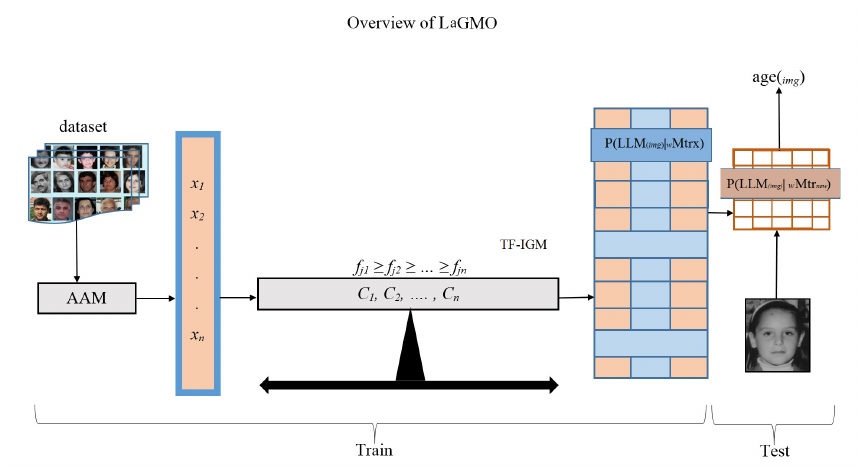
Figure 2. Overview of the proposed LaGMO. P p LLM p img q | w Mtrx new q is the predictive